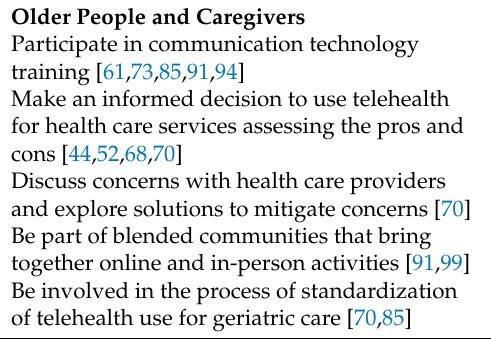
Table 2. Recommendations for improving telehealth services for older